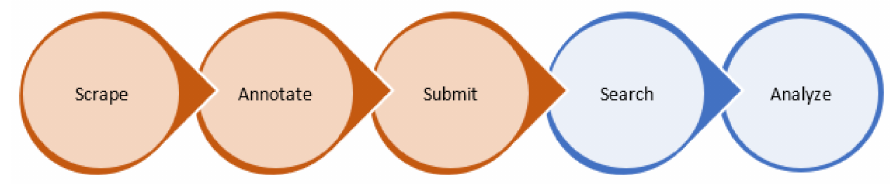
Figure 2. The private (orange) and public (blue) functionality of the PHARM